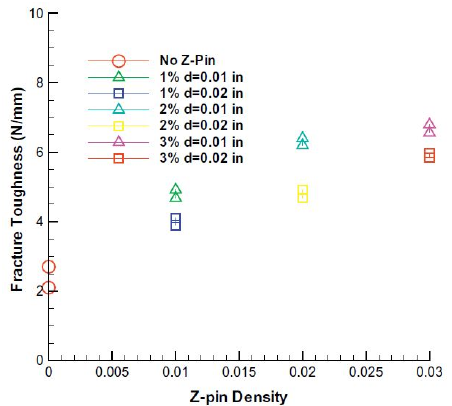
Figure 59. E ff ect of increasing z-Pin content and diameter on mode II fracture toughness of z-Pinned laminates (CFRP z-Pins, [±45/0/90] pre-preg) [48].